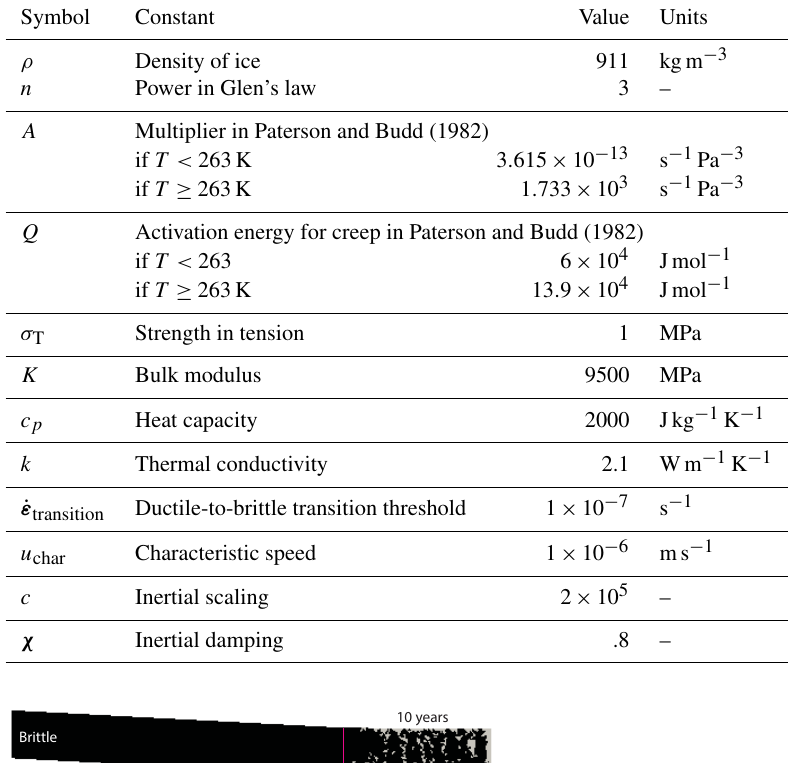
Table 1. Numerical and material parameters used in model runs whose values remained constant.